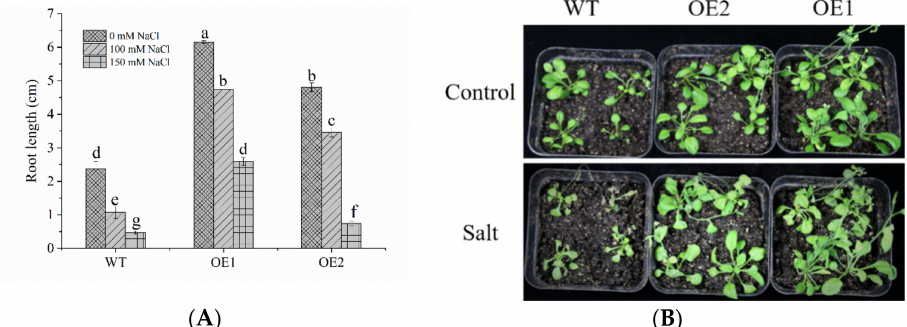
Figure 8. Overexpression of CaHSP18.1a enhanced tolerance to salt stress. ( A ) Root length of wild-type (WT) and CaHSP18.1a -OE Arabidopsis lines grown for 10 d on Murashige and Skoog (MS) medium containing 0, 100, and 150 mM NaCl. ( B ) Seedling growth for WT and transgenic plants exposed to NaCl. Three-week-old seedlings were watered with 200 mM NaCl once every 1–2 days. The images were taken after 7